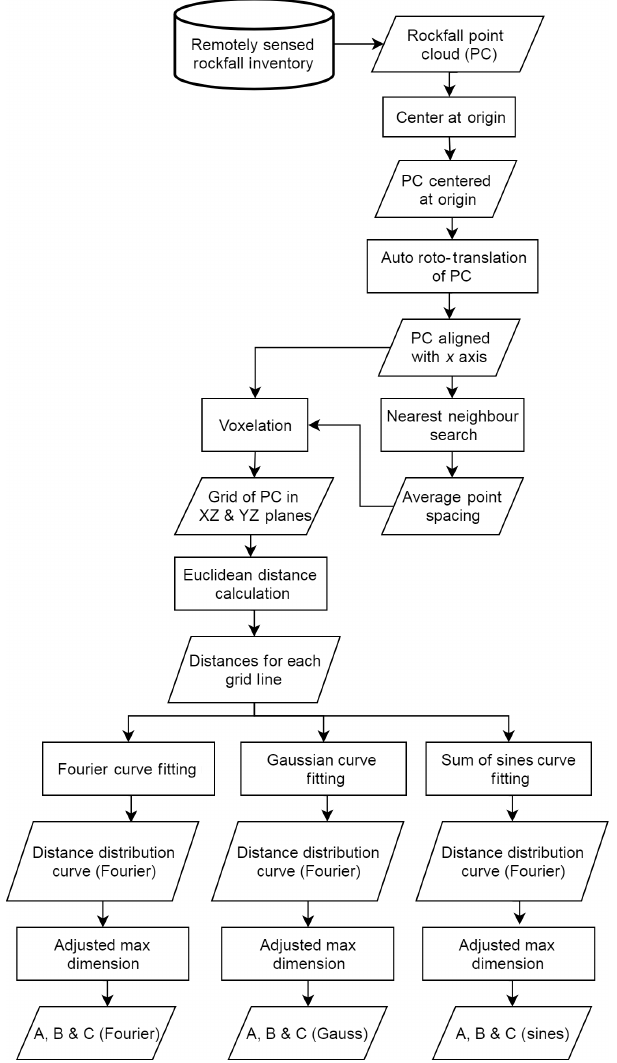
Figure 7. Structured flow chart of the RFSHAPZ algorithm.